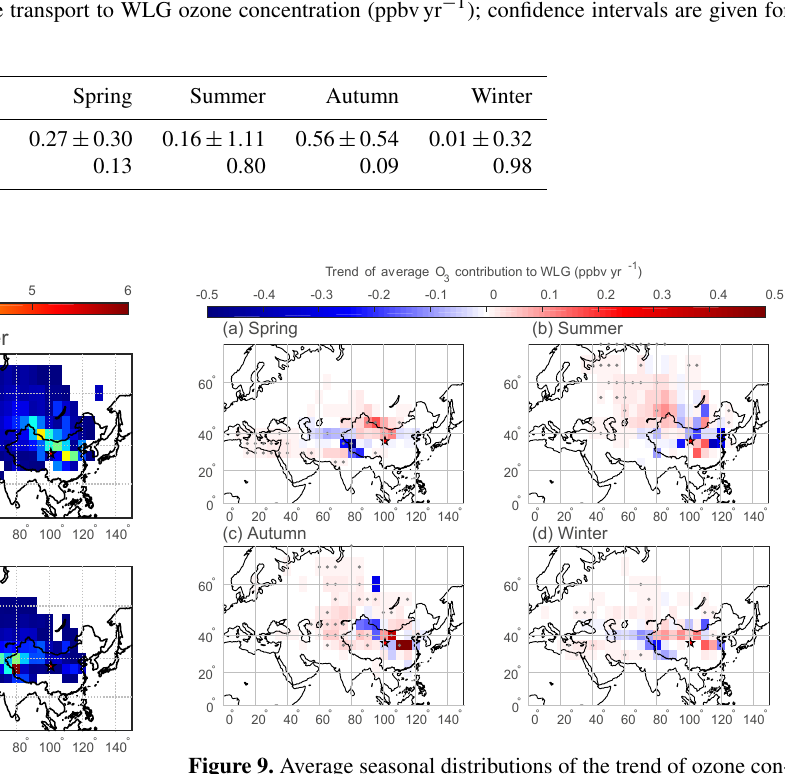
Figure 8. Average seasonal distributions of ozone contribution to WLG through direct transport of ozone during 1994–2013.